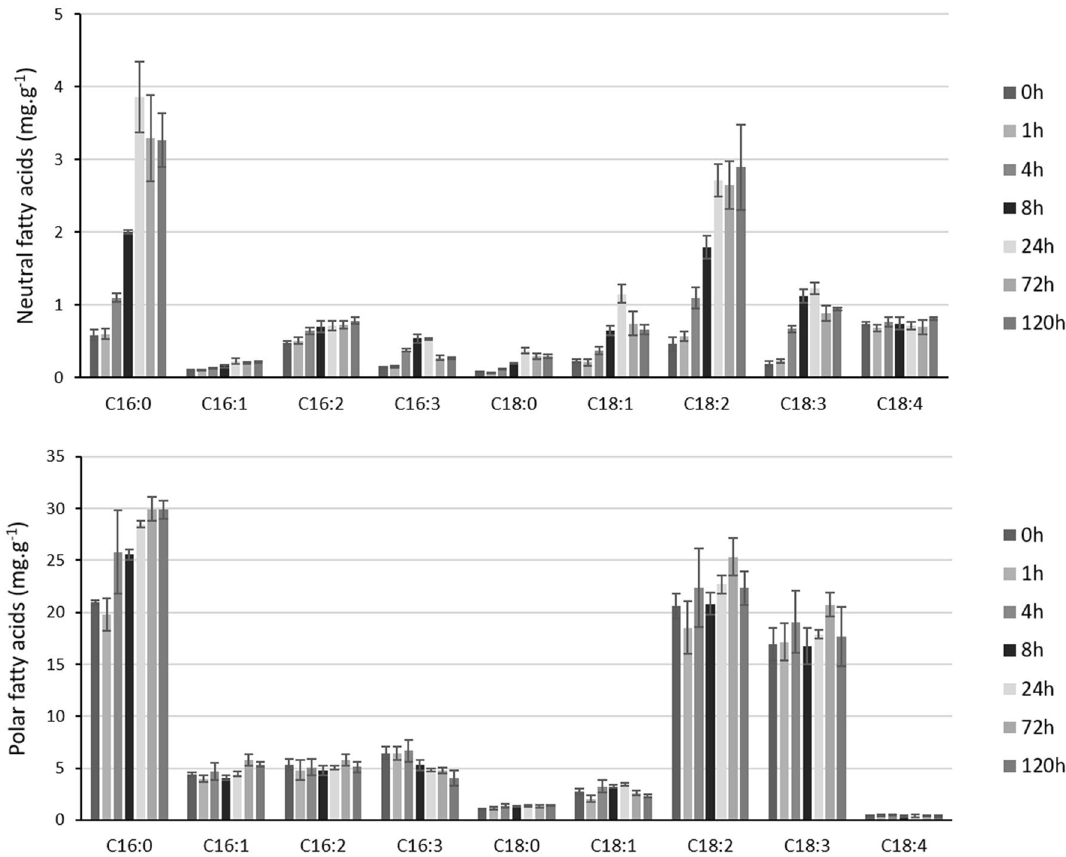
Figure 3. Neutral fatty acid and polar fatty acid concentrations as measured over time, starting at the moment of the temperature increase from 30 to 42 °C. Data represents the mean ± standard deviation of biological triplicate